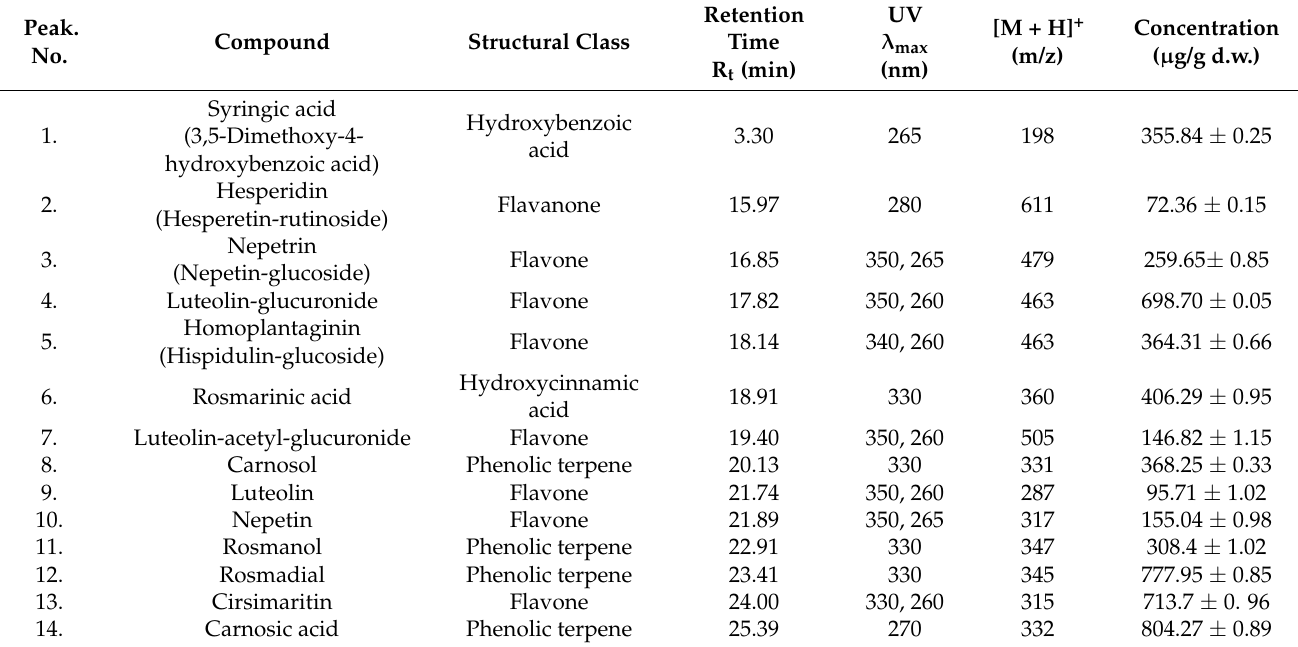
Table 1. Phenolic compounds identified in R. officinalis extract by HPLC–UV–MS.